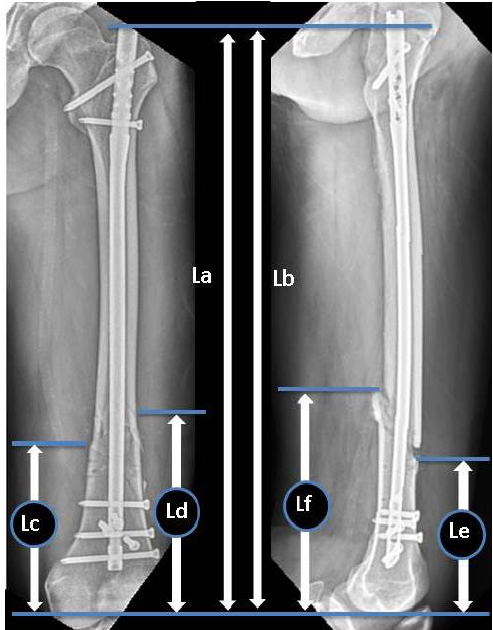
Figure 1. Ratio of the distal fragment: D/L, L: (La + Lb)/2, D: (Lc + Ld + Le + Lf)/4. D: Main distal fragment length, L: femur length, La: distance from the tip of the greater trochanter to the intercondylar notch in the AP view, Lb: distance from the tip of the greater trochanter to the intersection of the Blumensaat line and the trochlear groove line in the lateral view, Lc: distance from the intercondylar notch to the distal fracture line at the lateral site in the AP view, Ld: distance from the intercondylar notch to the distal fracture line at the medial site in the AP view, Le: distance from the intercondylar notch to the distal fracture line at the anterior site in the lateral view, Lf: distance from the intercondylar notch to the distal fracture line at the posterior site in the lateral view.